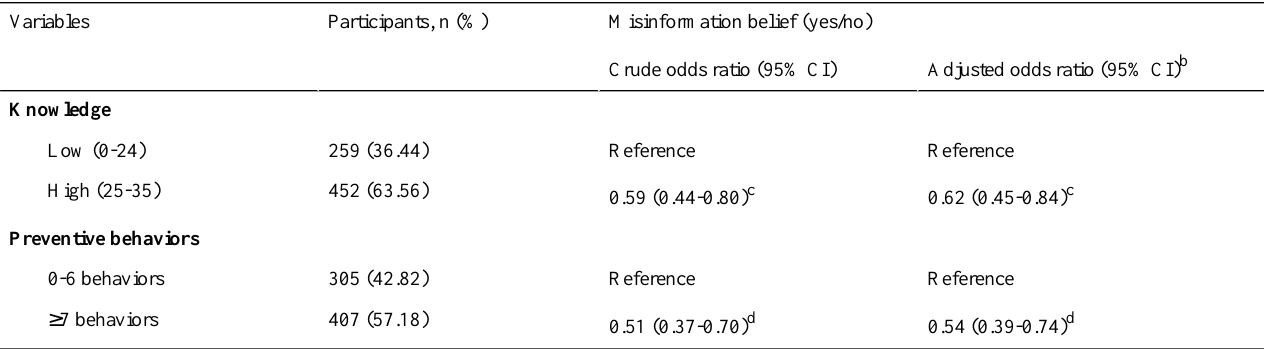
Table 4. Associations of COVID-19 knowledge and number of COVID-19 preventive behaviors with COVID-19 misinformation belief among respondents who were exposed to misinformation (N=711) a